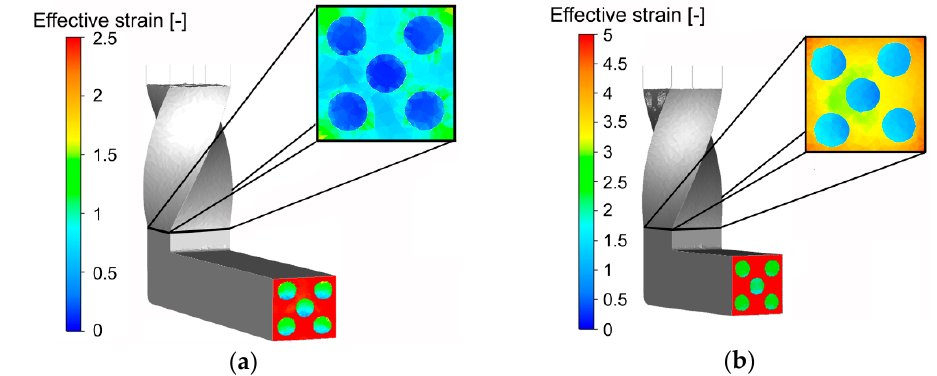
Figure 4. Effective imposed strain during: first pass ( a ); second pass ( b ).